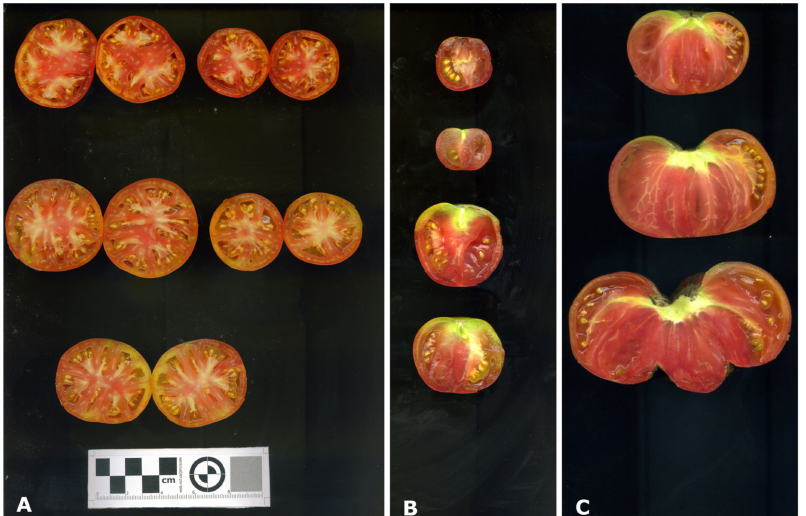
Figure 1. ( A ): Fruits from the third, fourth and fifth clusters, from top to bottom, harvested at one event from a single plant of accession SLY49. ( B ): Fruits from the third cluster of different plants of the accession SLY49. ( C ): Fruits from the third cluster from different plants of accession